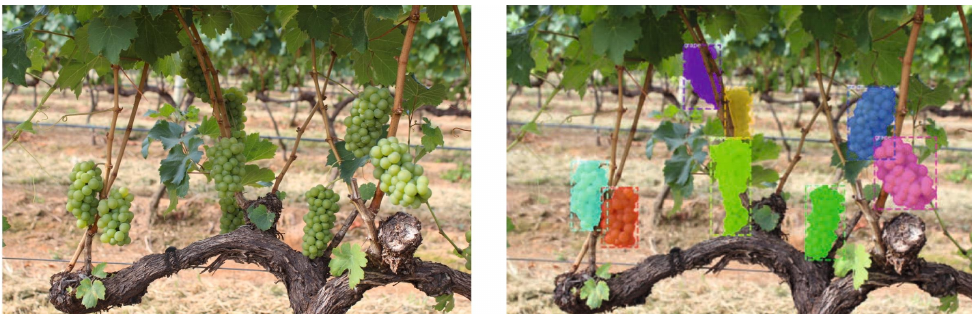
Figure 6. The left side shows the original image and the right side shows the task of segmentation for and the right side shows the task of segmentation for grapes [26]. Reprinted with permission from ref. [26]. Copyright 2020